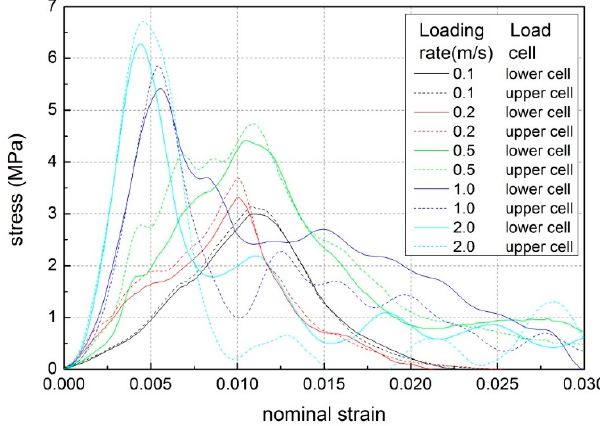
Figure 14. Typical stress versus nominal strain-rate profiles of soft ice with different loading rates at − 5 °C (results derived from the upper load cell are shown as dotted lines and results derived from the lower load cell are shown as solid lines).